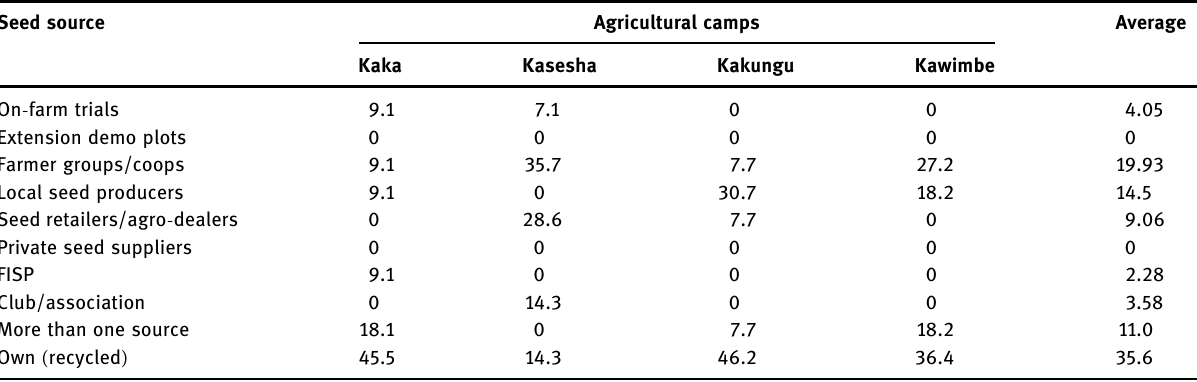
Table 4: Sources of seed for potato cultivation in Mbala district ( % of respondents ) Seed